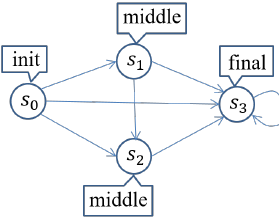
Figure 1. A simple system called SimpSys.